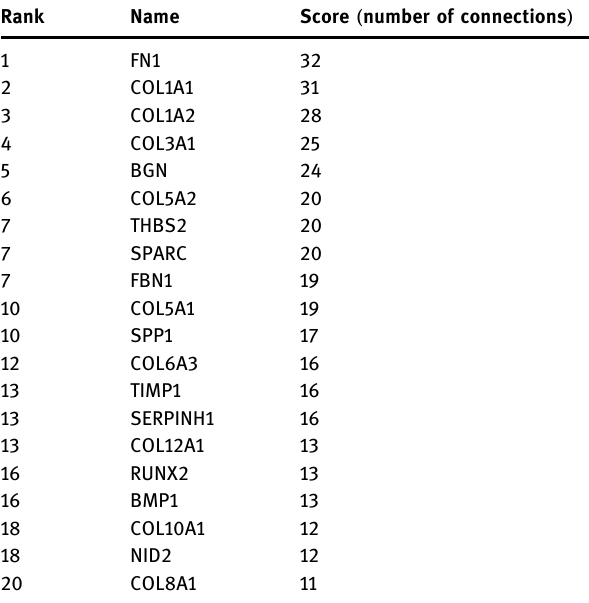
Table 2: The rankings of the hub genes based on connectivity Rank